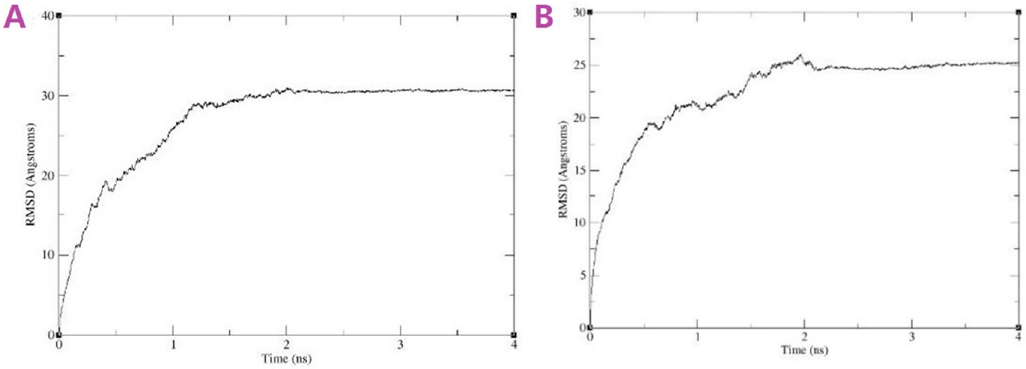
Figure 11. RMSD versus time of ( A ) PVP polymer segment and Cur complex and ( B ) POL polymer segment and Cur complex in 4 ns simulation.